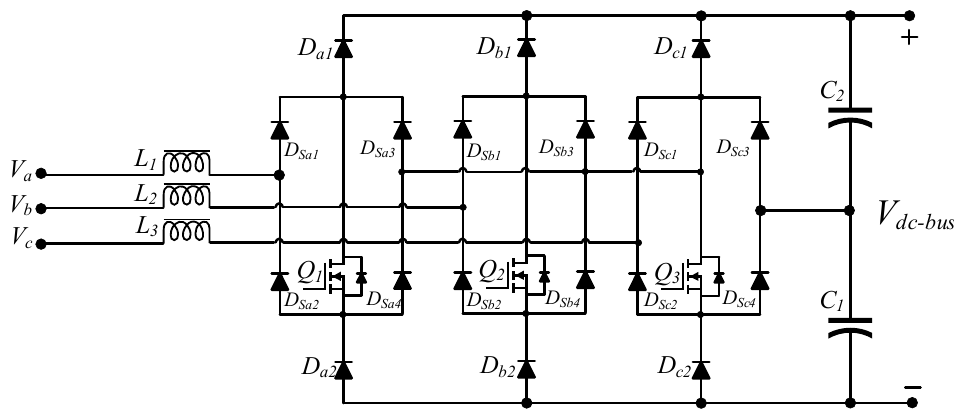
F igure 18. Three-phase Vienna rectifier. Figure 18. Three-phase Vienna